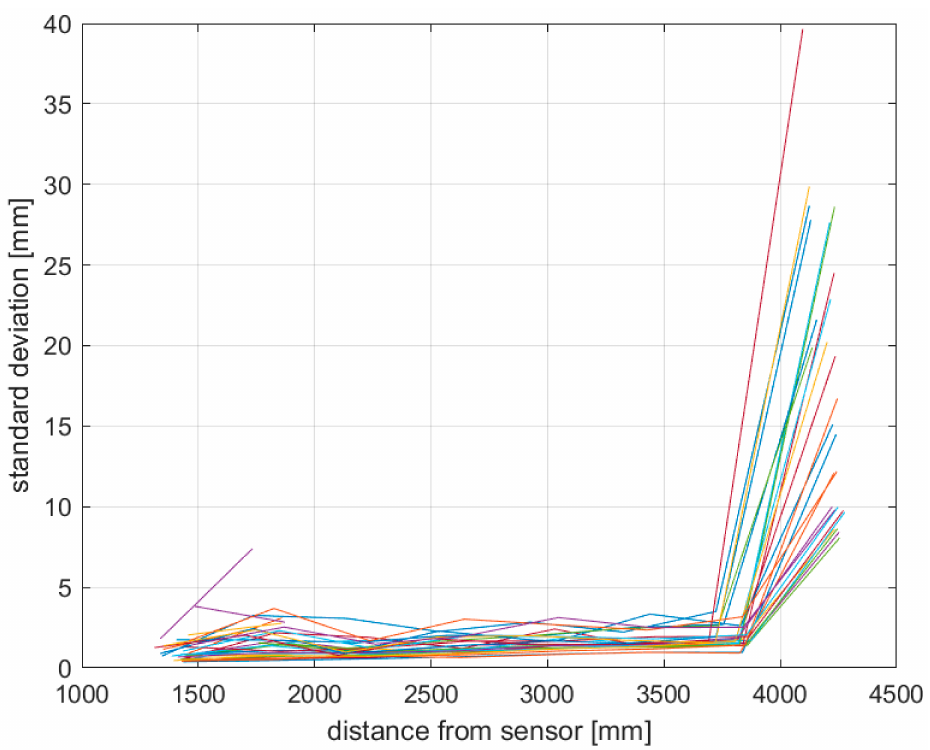
Figure 11. Body joint precision measurements of Azure Kinect in the NFOV